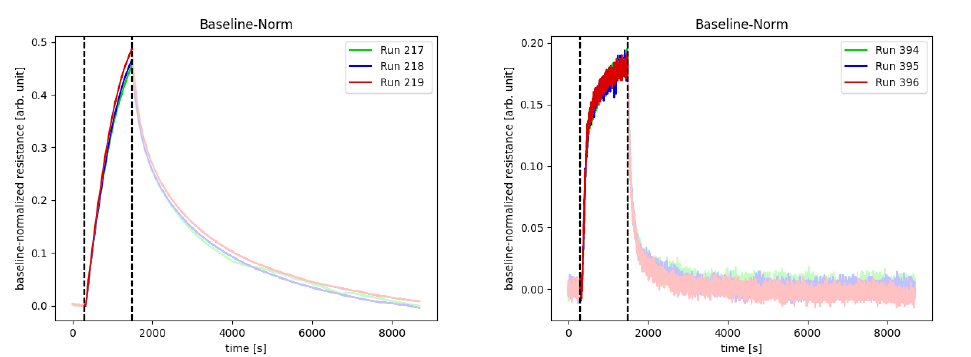
Figure 8. Midfield place of worst sensor in the